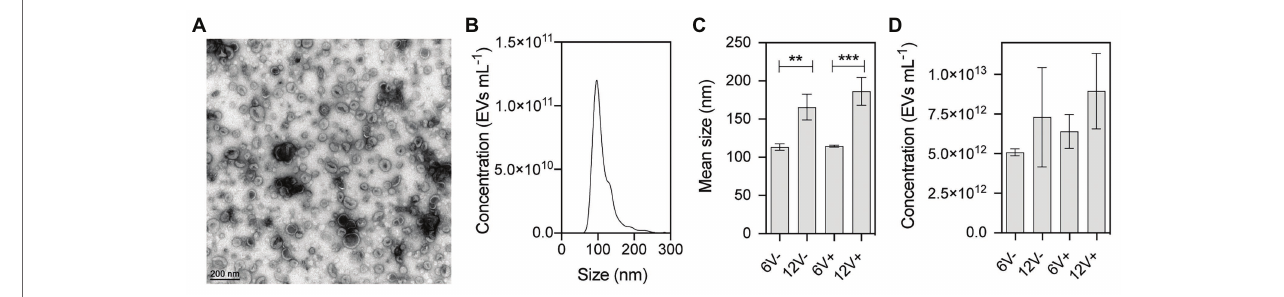
FIGURE 1 | Physical characterization of purified Staphylococcus aureus HG003-secreted extracellular vesicles (EVs). (A) Representative electron microscopy image of negatively stained HG003 EVs. (B) Representative graph of the EV size distribution. (C) Mean EV sizes. (D) EV yields. Data were obtained from three independent EV replicates. Asterisks indicate statistical significance (one-way ANOVA followed by Tukey’s multiple comparisons test: ** p < 0.01; *** p < 0.001). Early- and late-stationary growth phases (6 and 12, respectively) in the absence (V − ) or presence (V+) of